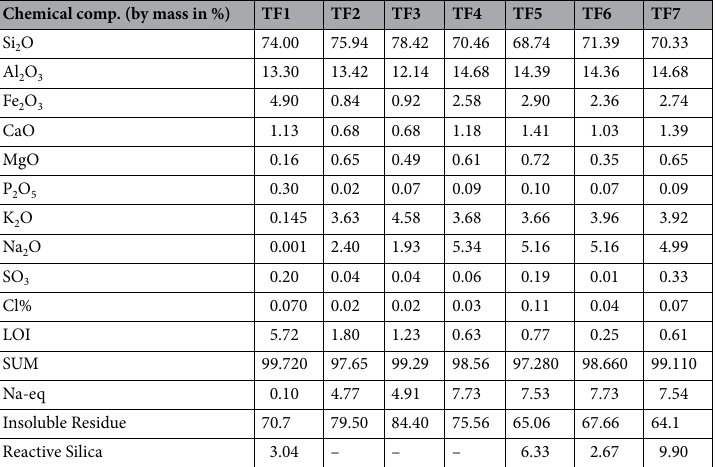
Chemical comp. (by mass in